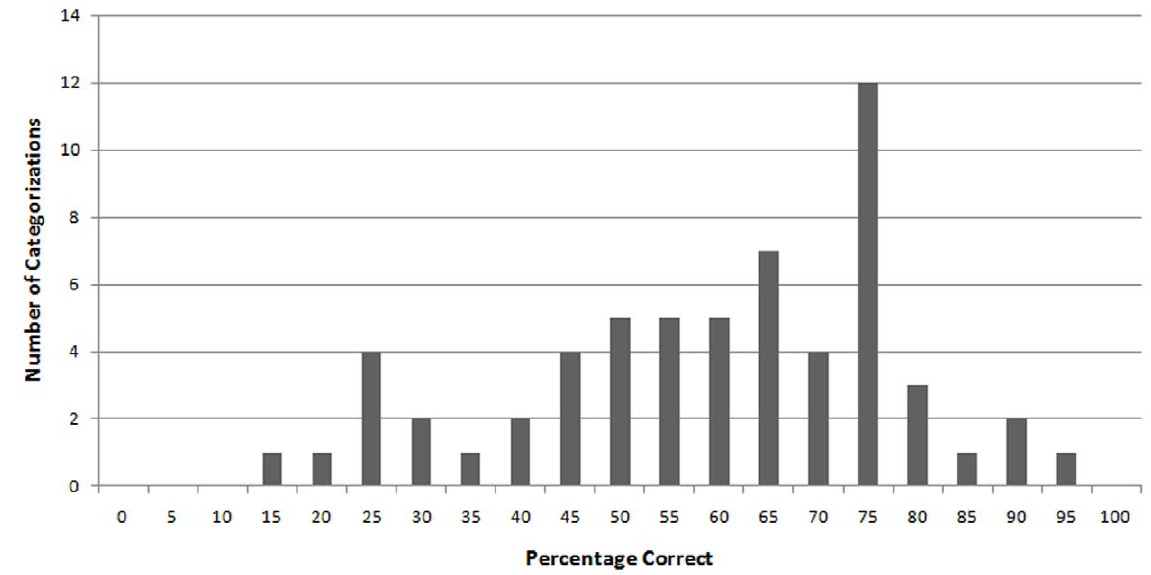
Figure 2. Frequency of accurate categorizations of targets as Democrats and Republicans in Study 2 according to 5% bins.